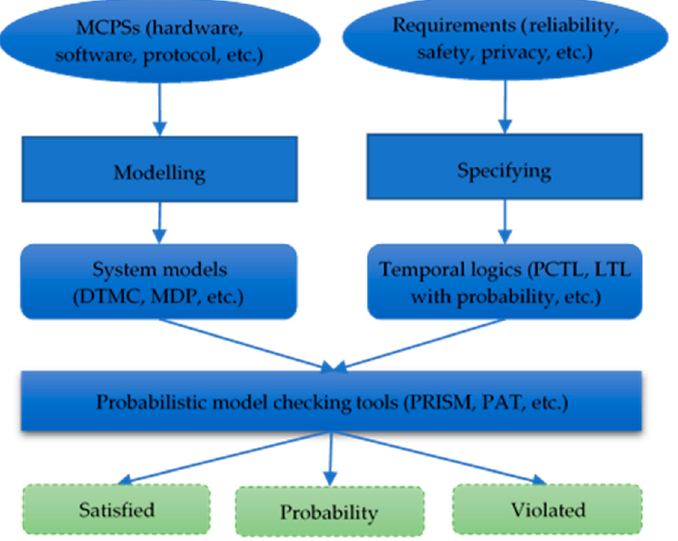
Figure 1. Schematic view of estimating MCPSs by probabilistic model checking.